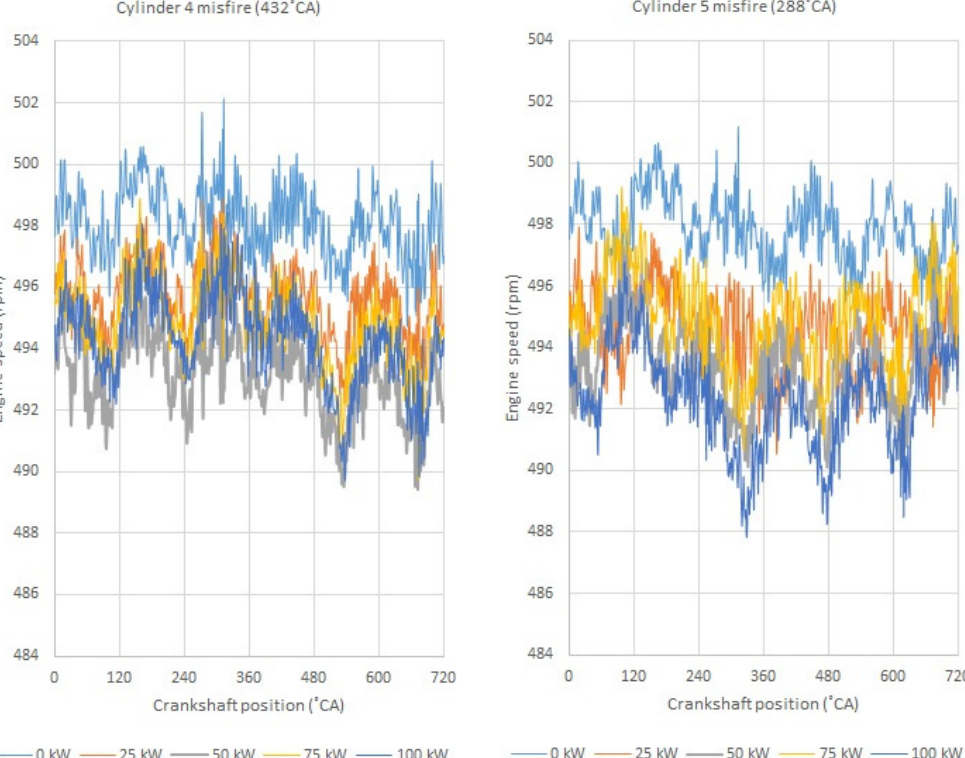
Figure 20. Instantaneous speeds at the moment of combustion loss in cylinders 4 and 5 of a Sulzer 5 BAH 22 engine for pre-set electrical loads of 0–100 kW.